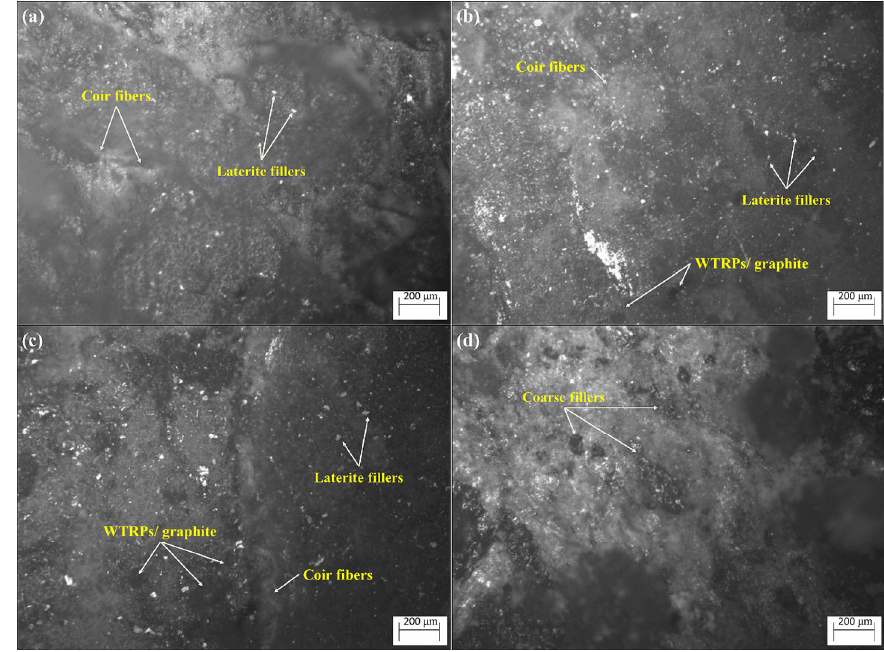
Fig. 4 Optical micrographs: (a) W-I, (b) W-II, (c) W-III, and (d)